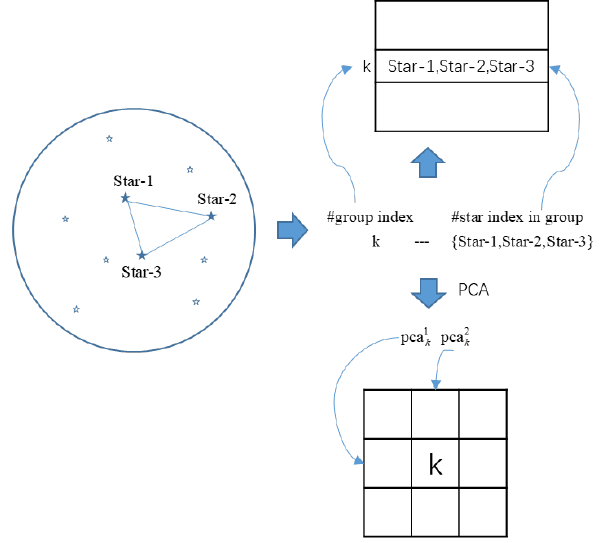
Figure 3. Feature unit storing process in the database.